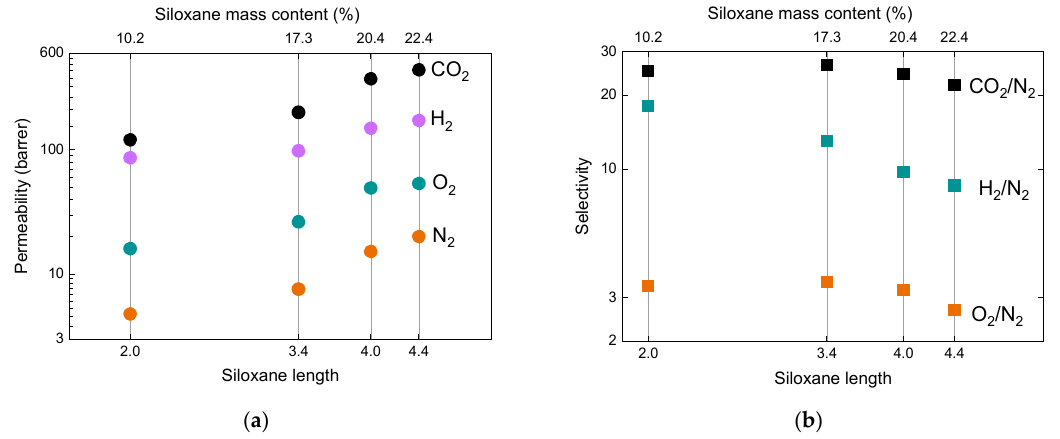
Figure 7. ( a ) Permeability of measured gases (H 2 , CO 2 , O 2 , N 2 ) in DMS@POSS membranes as a function of DMS linker length (or total DMS mass content, upper x-scale) suggesting that it is the main factor defining the gas transport through the membranes; ( b ) Selectivity of the important gas pairs as a function of DMS content.